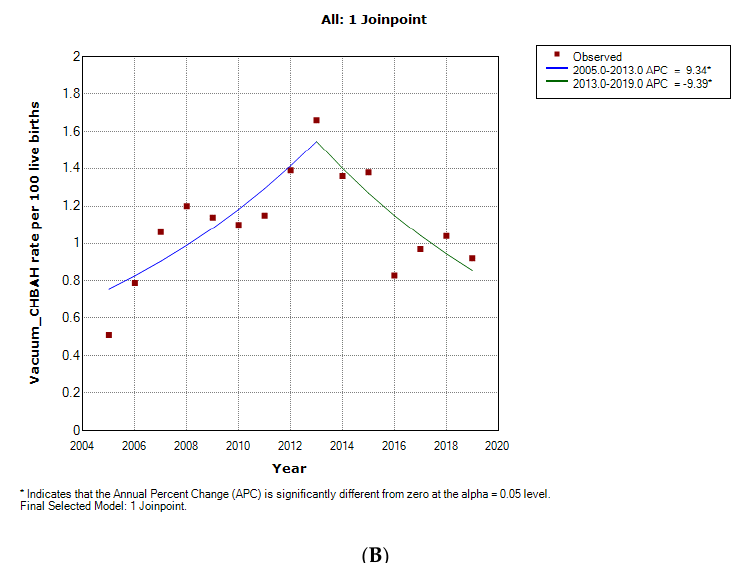
Figure 5. Join point regression analysis of the trends in forceps delivery ( A ) and Vacuum ( B ) rates at Chris Hani Baragwanath Academic Hospital (2005 – 2019).